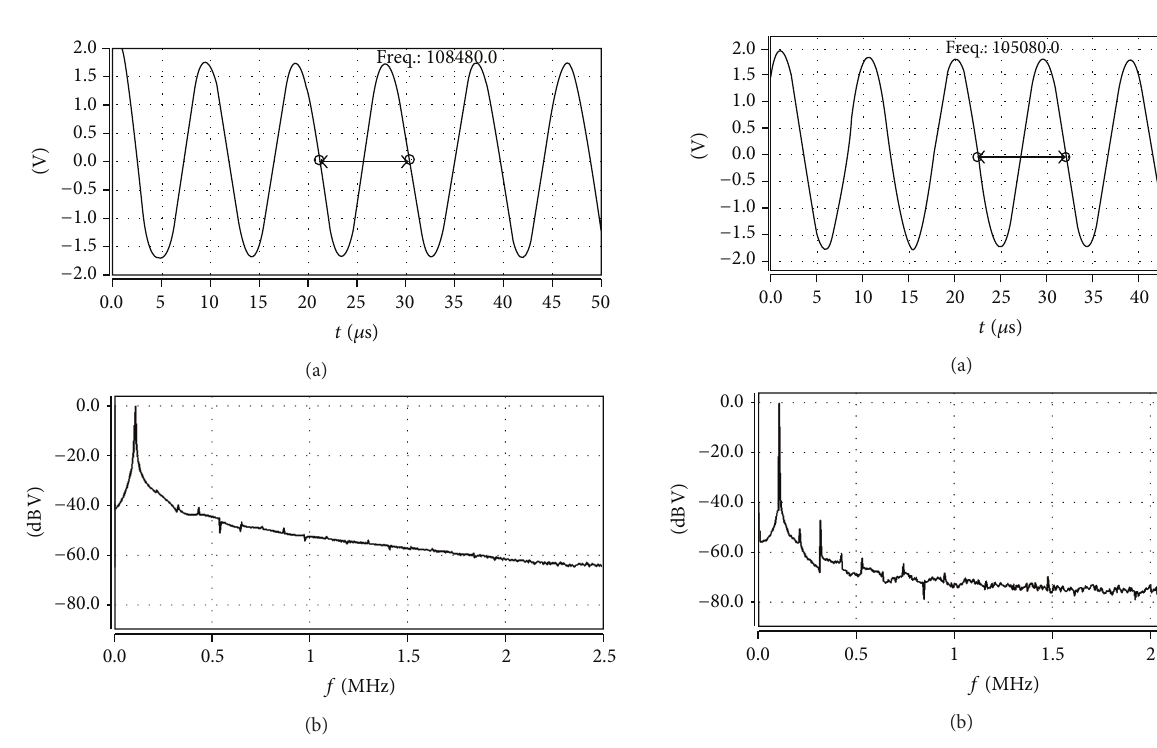
Figure 11: Simulation results for the circuit (Figure 4(c)) using CMOS OTRA (Figure 2): (a) output waveform and (b) correspond- ing frequency spectrum.